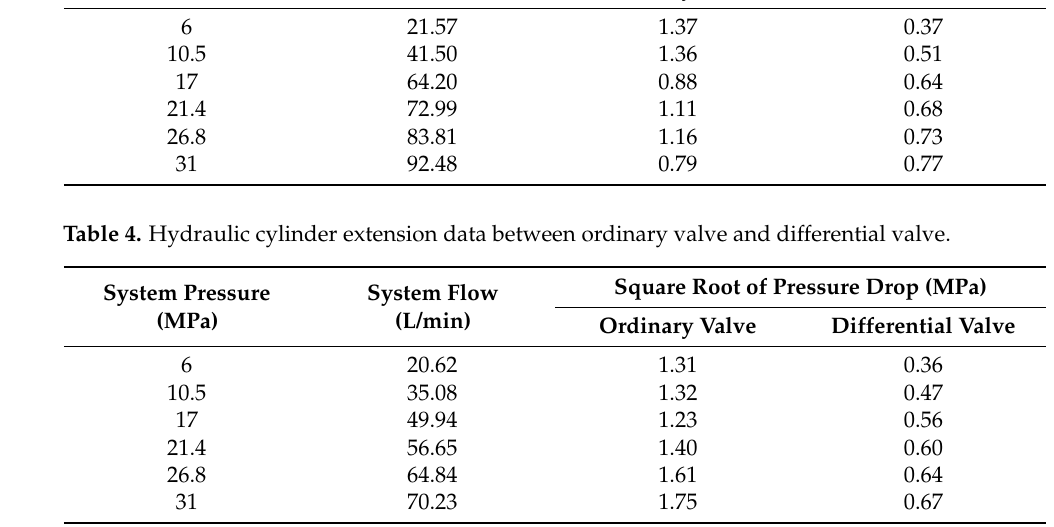
Figure 12. Connection of the hydraulic cylinder system.